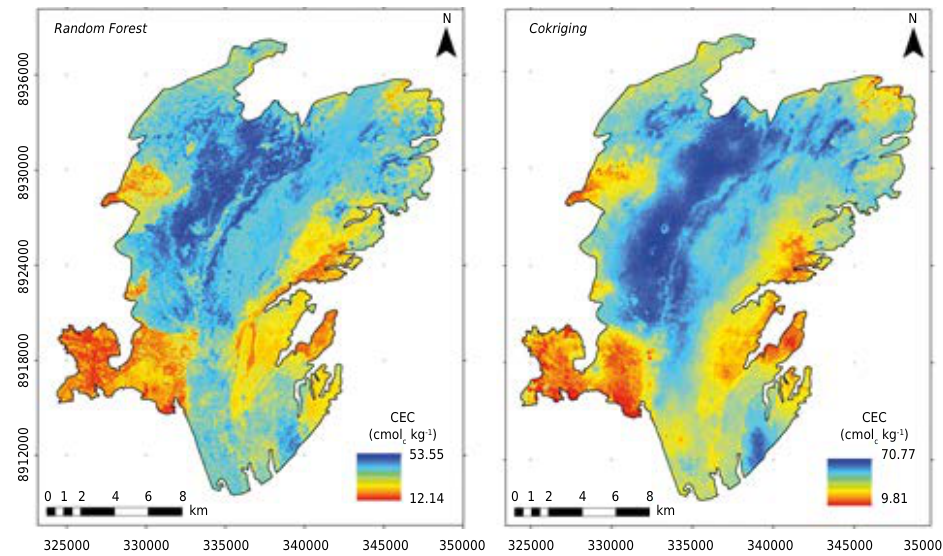
Figure 5. Spatial distribution of soil cation exchange capacity (CEC) estimated by the Random Forest and Cokriging